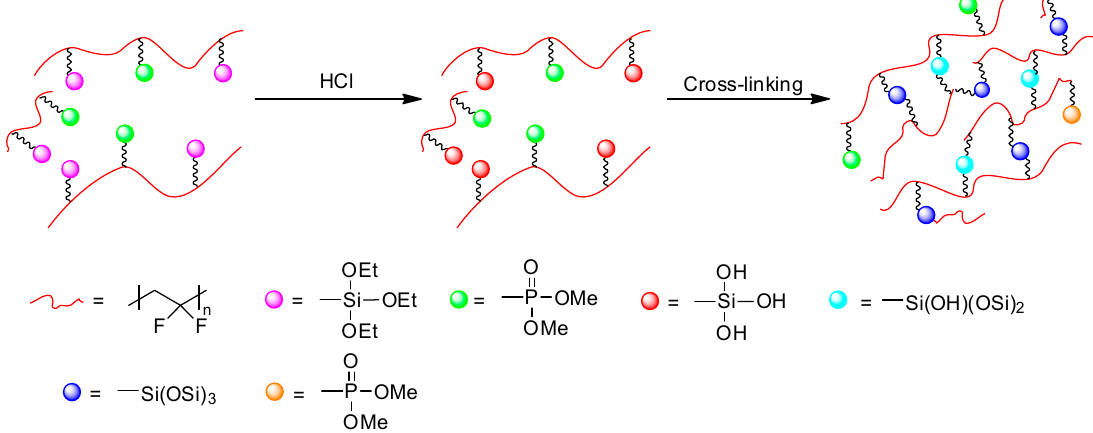
Figure 5. Sketch of hydrolysis and the polycondensation of dangling triethoxysilyl groups in poly(VDF- ter -VTEOS- ter -VDMP)